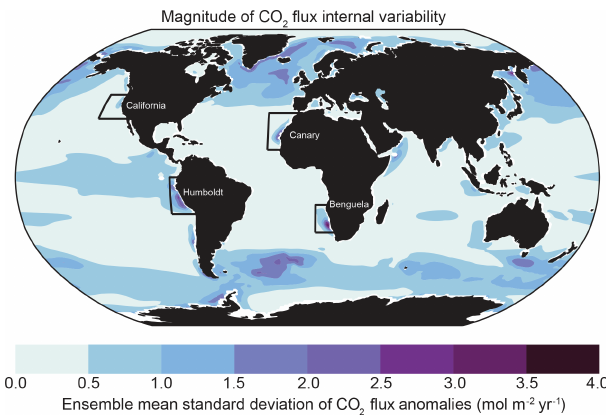
Figure 3. Magnitude of internal variability in CO 2 flux from 1920– 2015 in the CESM-LENS. Anomalies were generated by removing the ensemble mean – which represents the seasonality and forced signal – from each realization. Internal variability was then quanti- fied by taking the ensemble mean standard deviation of the anoma- lies from 1920–2015. Here, the black boxes outline the general do- main of the EBUSs in this study but do not coincide with the statis- tical boundaries shown in Fig.